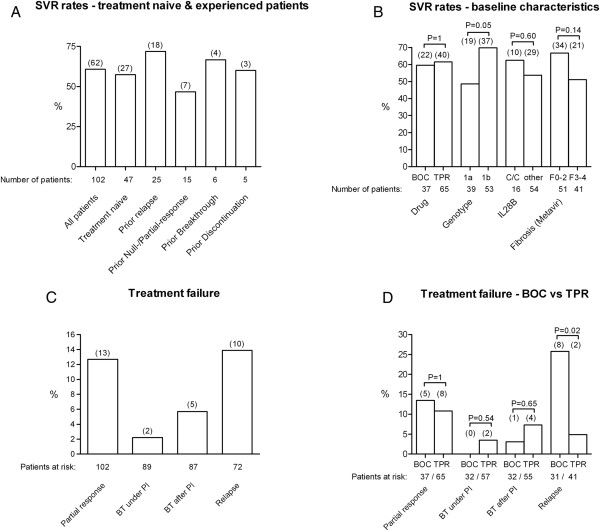
Efficacy of triple therapy. SVR rates for different subgroups are displayed in A and B, a characterization of treatment failures for the total study population [C] and for BOC versus TPR [D] are given, too. Patients who died after discontinuation of therapy (N = 3) and patients who were lost to follow up (N = 8) were not regarded as being at risk for relapse in C and D. [SVR = sustained virological response; BOC = boceprevir; TPR = telaprevir; IL28B = interleukin 28B polymorphism; BT = breakthrough; PI = protease inhibitor].